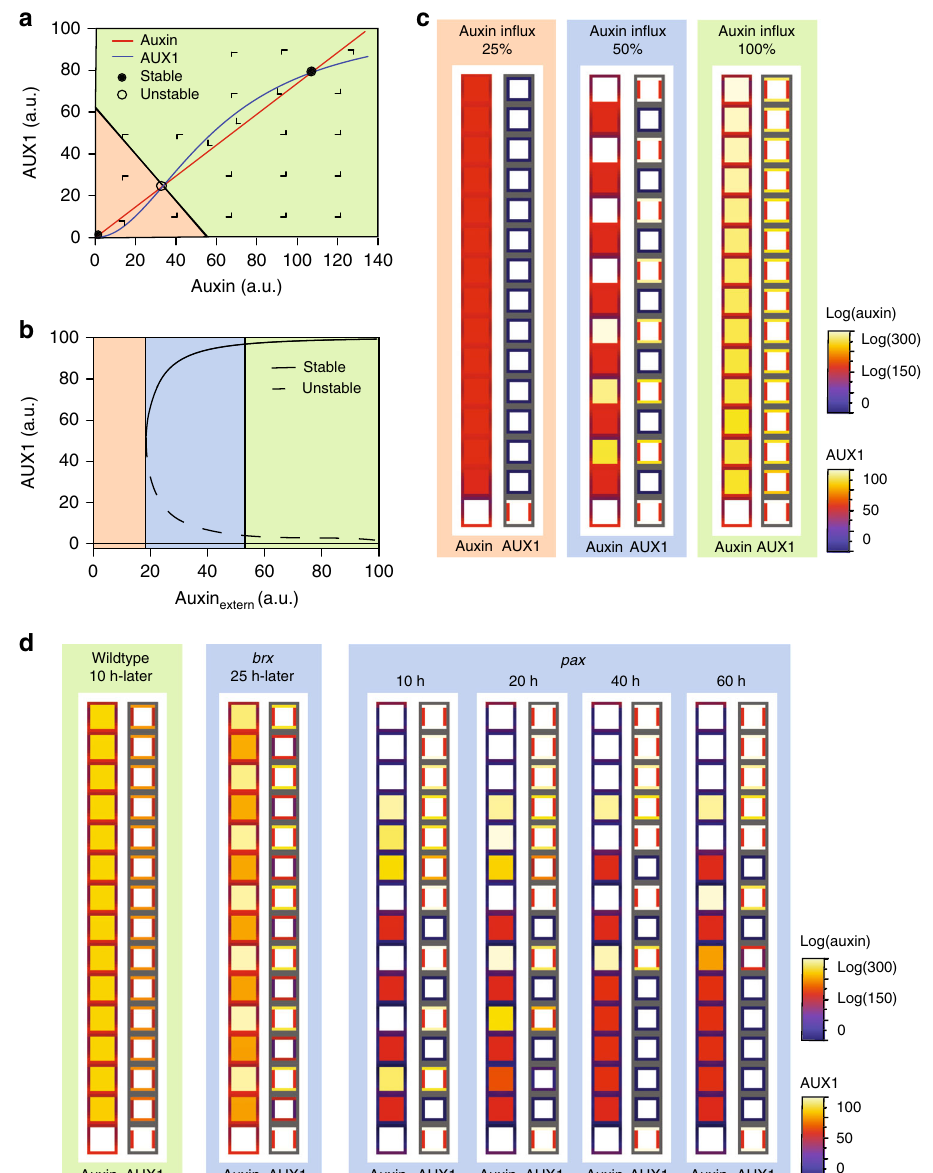
Fig. 3 AUX1-dependent bistability. a Phase portrait of the auxin – AUX1 single-cell model for intermediate external auxin levels, showing auxin- and AUX1- null clines, the stable and unstable equilibrium intersection points, and the basins of attraction for low auxin-low AUX1 (LALA) (orange) and high auxin- high AUX1 (HAHA) (green) stable equilibria. b Bifurcation diagram of the auxin – AUX1 single-cell model using external auxin as the bifurcation parameter. Note the bistable parameter domain in which both the LALA and HAHA equilibria exist (blue). c Snapshots of steady-state auxin and AUX1 patterns in a 15-cell strand auxin – AUX1 model for varying levels of shoot-derived auxin in fl ux. Background colors indicate correspondence with parameter regions shown in ( b ). d Snapshots for simulated brx mutants, pax mutants and wild type under constant shoot auxin in fl ux (showing steady-state dynamics for brx and wild type, and patterning dynamics for pax